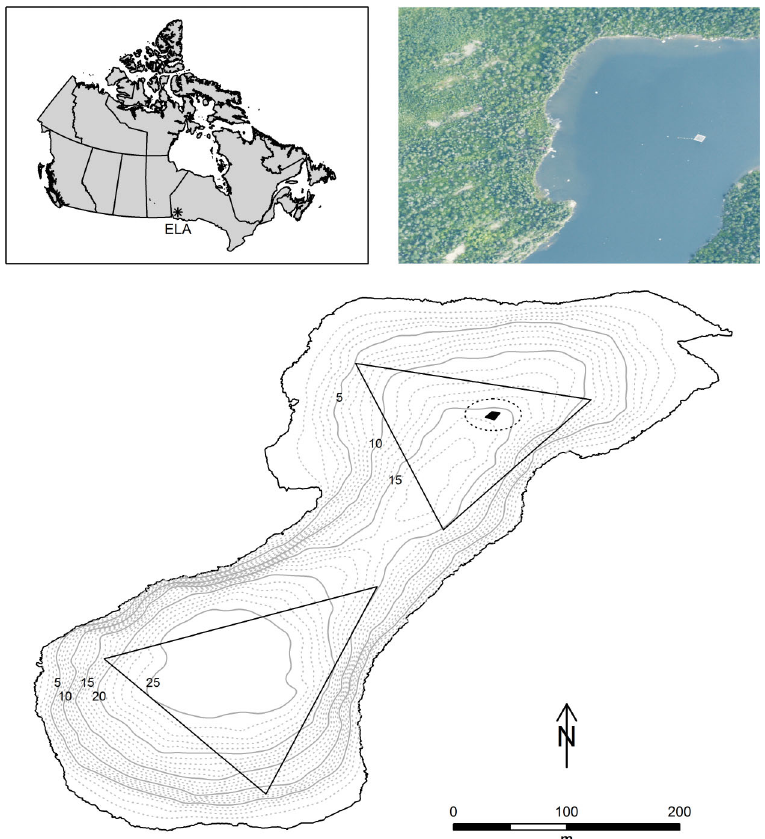
Fig. 1. Location of the Experimental Lakes Area (ELA) in northwestern Ontario, Canada (inset top left), where a model aquaculture facility that annually pro- duced 10 t of rainbow trout Oncorhynchus mykiss from 2003−2007 was in oper- ation in the north basin of Lake 375 (aerial photo, top right). Bathymetric map of Lake 375 with solid grey lines that represent 5 m depth contours in each basin are shown. We considered all fish positions inside the 5 m isopleth as ‘littoral’ and those at isopleths >5 m as ‘pelagic’. The locations of the hydrophones for each of the 2 telemetry systems are represented by the points of the triangles in the north and south basins. The cage (solid black square) with 25 m radius buffer (dashed black line) is also